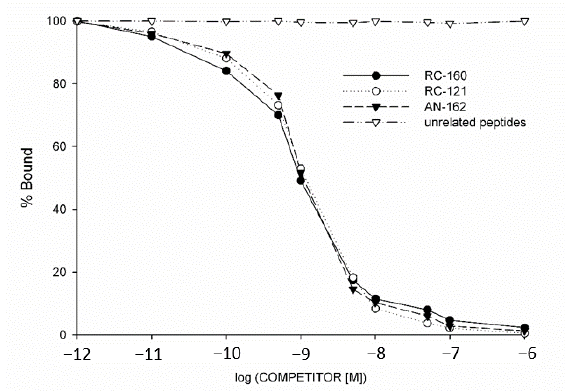
Figure 3. Representative displacement of [ 125 I]RC-160 binding to membrane fractions of human rhabdomyosarcoma specimen by increasing concentrations of somatostatin (SST) analog RC-160 (Vapreotide) (●), cytotoxic SST analog AN-162 ( ▼ ) and RC-121, carrier peptide of AN-162 ( ○ ). Other unrelated peptides like LHRH, GHRH, VIP, bombesin, and epidermal growth factor ( ▽ ) did not